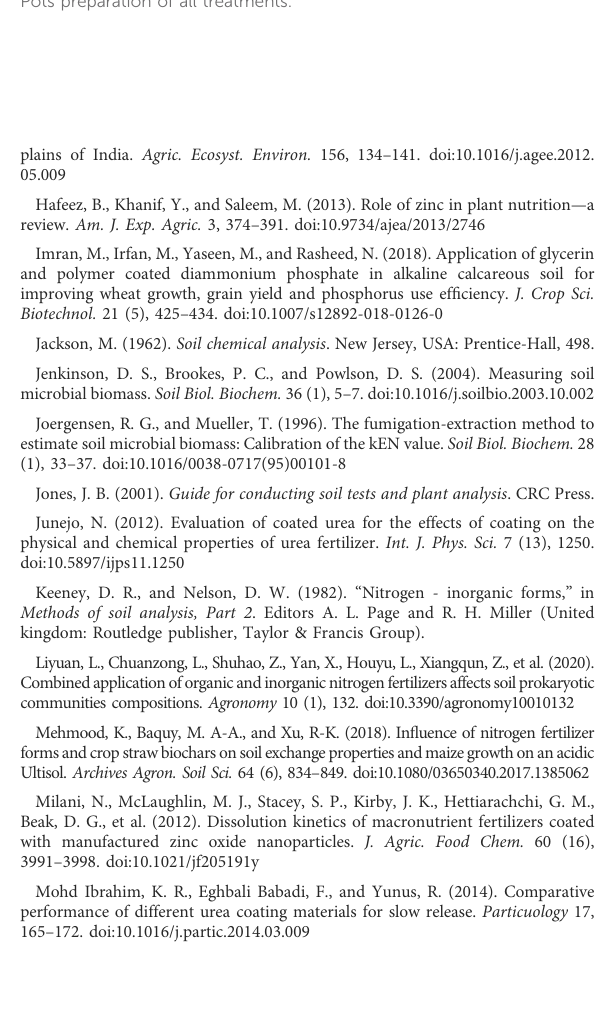
SUPPLEMENTARY FIGURE S1 Plants before fi rst harvest. SUPPLEMENTARY FIGURE S2 Calibration curve between concentration and absorbance of known samples of urea. SUPPLEMENTARY FIGURE S3 Pots preparation of all